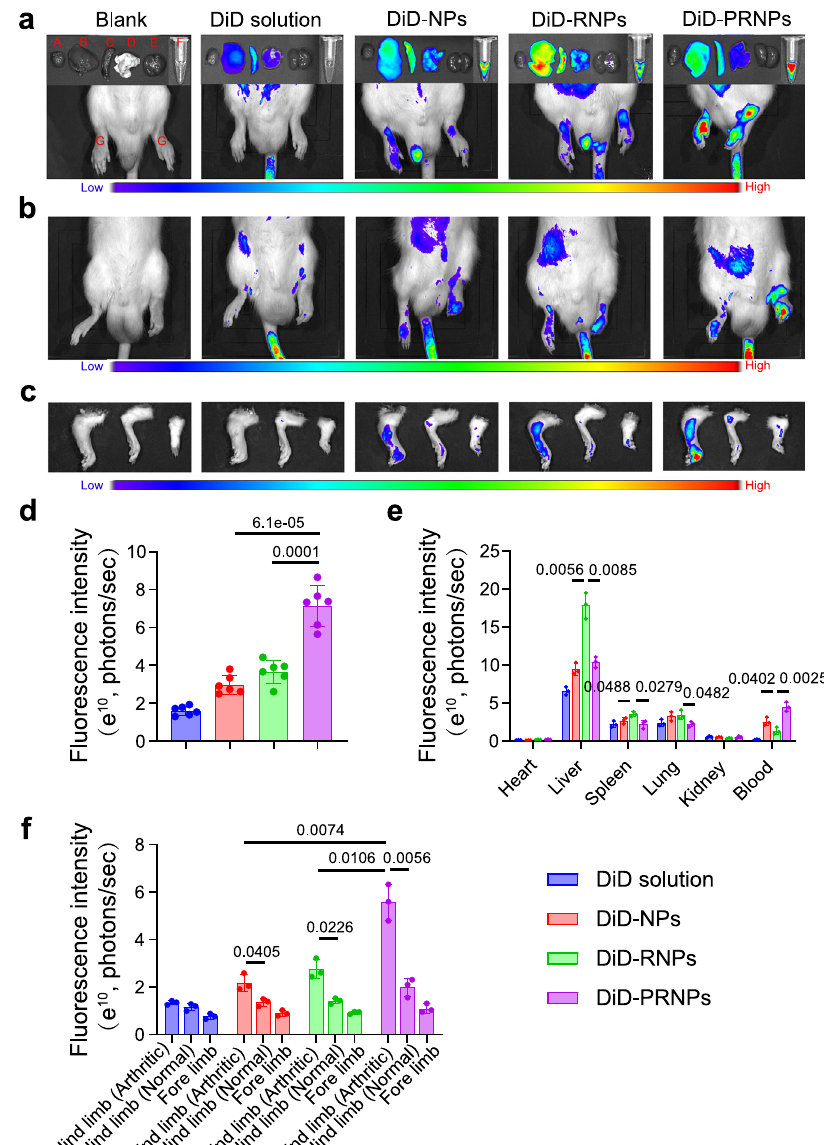
Fig. 5 PRNPs selectively accumulate in in fl amed joints of rats with advanced arthritis. a Ex vivo DiD fl uorescence images showing the biodistribution of NPs, RNPs, and PRNPs in AIA rats with advanced arthritis (A, heart; B, liver; C, spleen; D, lung; E, kidney; F, Blood; G, arthritic joint) at 24 h post injection. b In vivo DiD fl uorescence images showing the arthritic joint distribution of free DiD, and DiD-loaded NPs, RNPs, and PRNPs in AIA rats with a unilateral in fl amed joint at 24 h post injection. c Ex vivo DiD fl uorescence images in the in fl amed joints and un-in fl amed joints from AIA rats with a unilateral in fl amed joint at 24 h post injection with free DiD, and DiD-labeled NPs, RNPs, or PRNPs. d The statistical graphs of the fl uorescence intensity of in fl amed joints based on the semi-quantitative analysis of the ex vivo fl uorescence images after i.v . administration of free DiD or DiD-labeled nanoparticles. Data represent mean ± SD ( n = 6 in fl amed joints from 3 independent animals). Statistical signi fi cance was determined by two-sided Student ’ s t test. e The statistical graphs of the fl uorescence intensity of major organs from AIA rats with advanced arthritis after i.v. administration of free DiD or DiD-labeled nanoparticles. Data represent mean ± SD ( n = 3 independent animals). Statistical signi fi cance was determined by a two-sided Student ’ s t test. f The statistical graphs of the fl uorescence intensity of in fl amed joints and un-in fl amed joints from AIA rats with a unilateral in fl amed joint after i.v. administration of free DiD or DiD-labeled nanoparticles. Data represent mean ± SD ( n = 3 independent animals). Statistical signi fi cance was determined by a two-sided Student ’ s t test. DiD 1,1 ′ -dioctadecyl-3,3,3 ′ ,3 ′ -tetramethyl indodicarbocyanine, 4-chlorobenzenesulfonate salt, DiD-NPs DiD labeled poly ( D , L - lactide-co-glycolide) (PLGA) nanoparticles, DiD-RNPs DiD-labeled RGD peptide-modi fi ed PLGA nanoparticles, DiD-PRNPs DiD-labeled matrix metalloproteinase 9 (MMP9)-cleavable polyethylene glycol (PEG)- and RGD peptide-modi fi ed PLGA